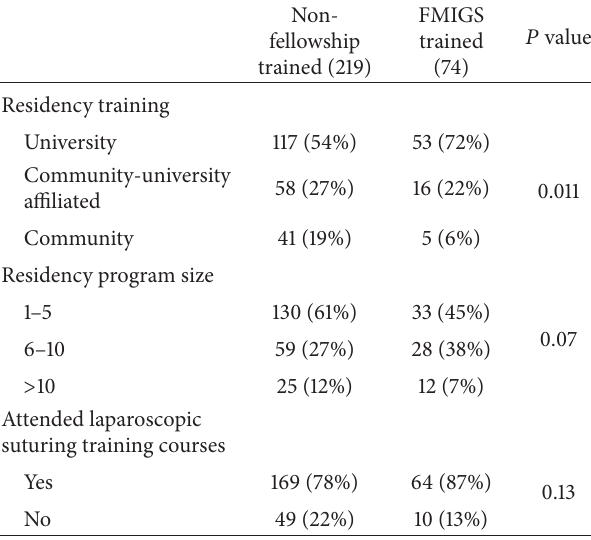
Table 2: Training background for study